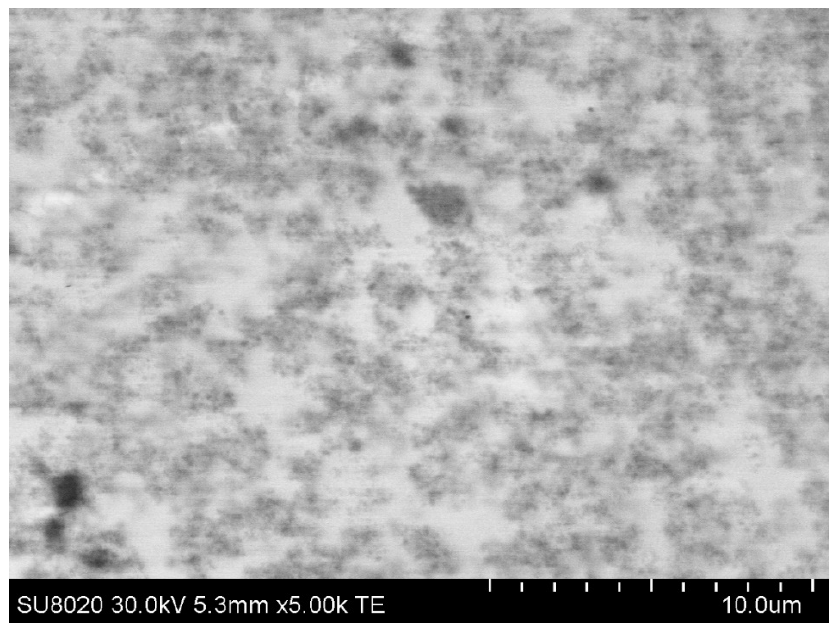
Figure 7. STEM image of epoxy nanocomposite coating containing 20 wt.% AHP NPs.